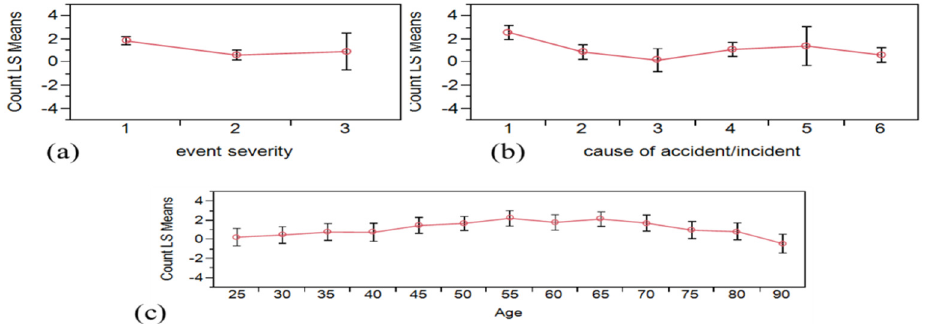
FIG..2: NUMBER OF ACCIDENTS (COUNT). a) 1-FATAL, 2-NON-FATAL, 3 INCIDENT b) 1-PILOT, 2-TECH, 3-WEATHER/WIND/year, 4-MORE THAN ONE, 5-OTHERS c)